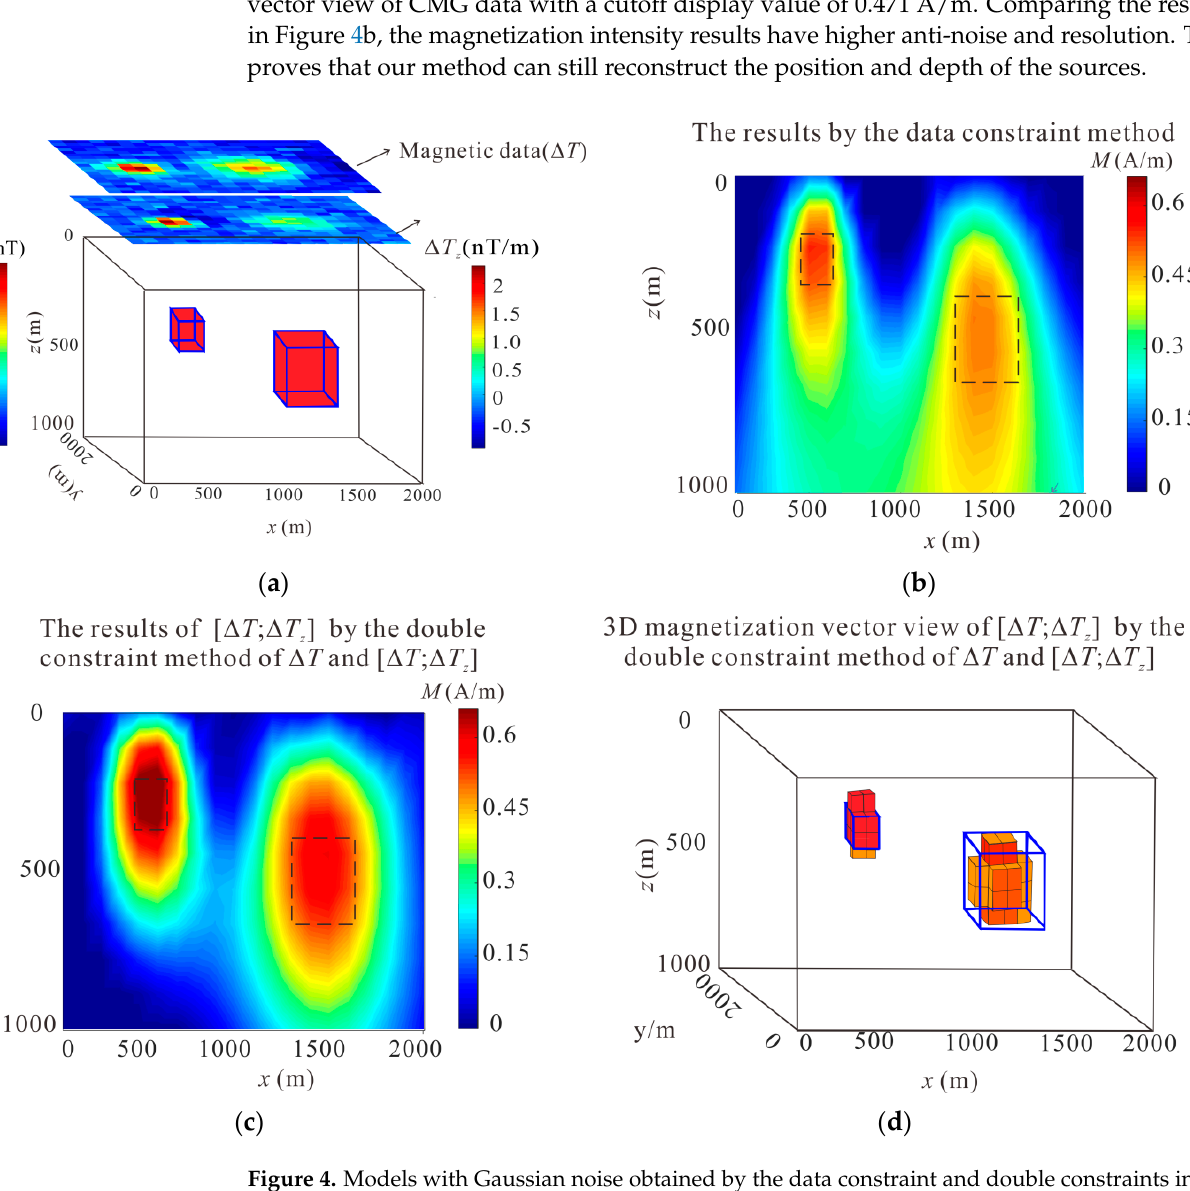
( d ) Figure 3. Models with different depths obtained by the double constraints inversion method of CMG data and different component airborne magnetic data. ( a , b ) The results of CMG data with Equation (10) and the corresponding 3D magnetization vector view with a cutoff value of 0.471 A/m,